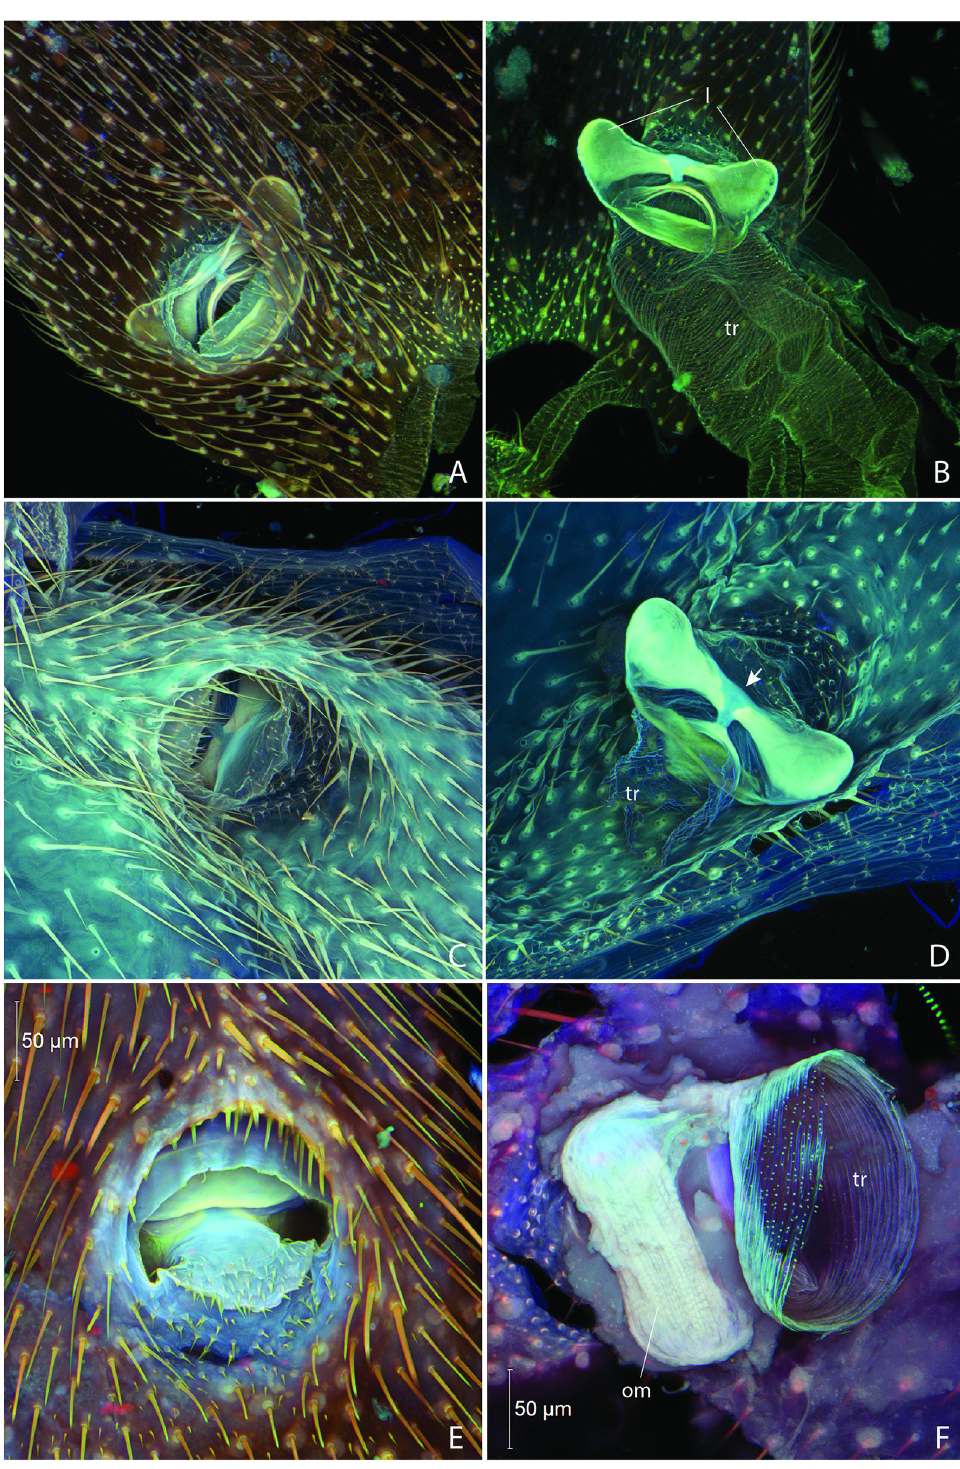
Fig 16. Adult male (A–D) and female (E–F) abdominal spiracles in Photinus pyralis . A, segment III spiracle, external view; B, segment III spiracle, internal view; C, segment VI spiracle, external view; D, segment VI spiracle, internal view; E, segment VI spiracle, external view; F, segment VI spiracle, internal view showing occlusor muscle. Abbreviations: l, lever; om, occlusor muscle; tr, trachea.